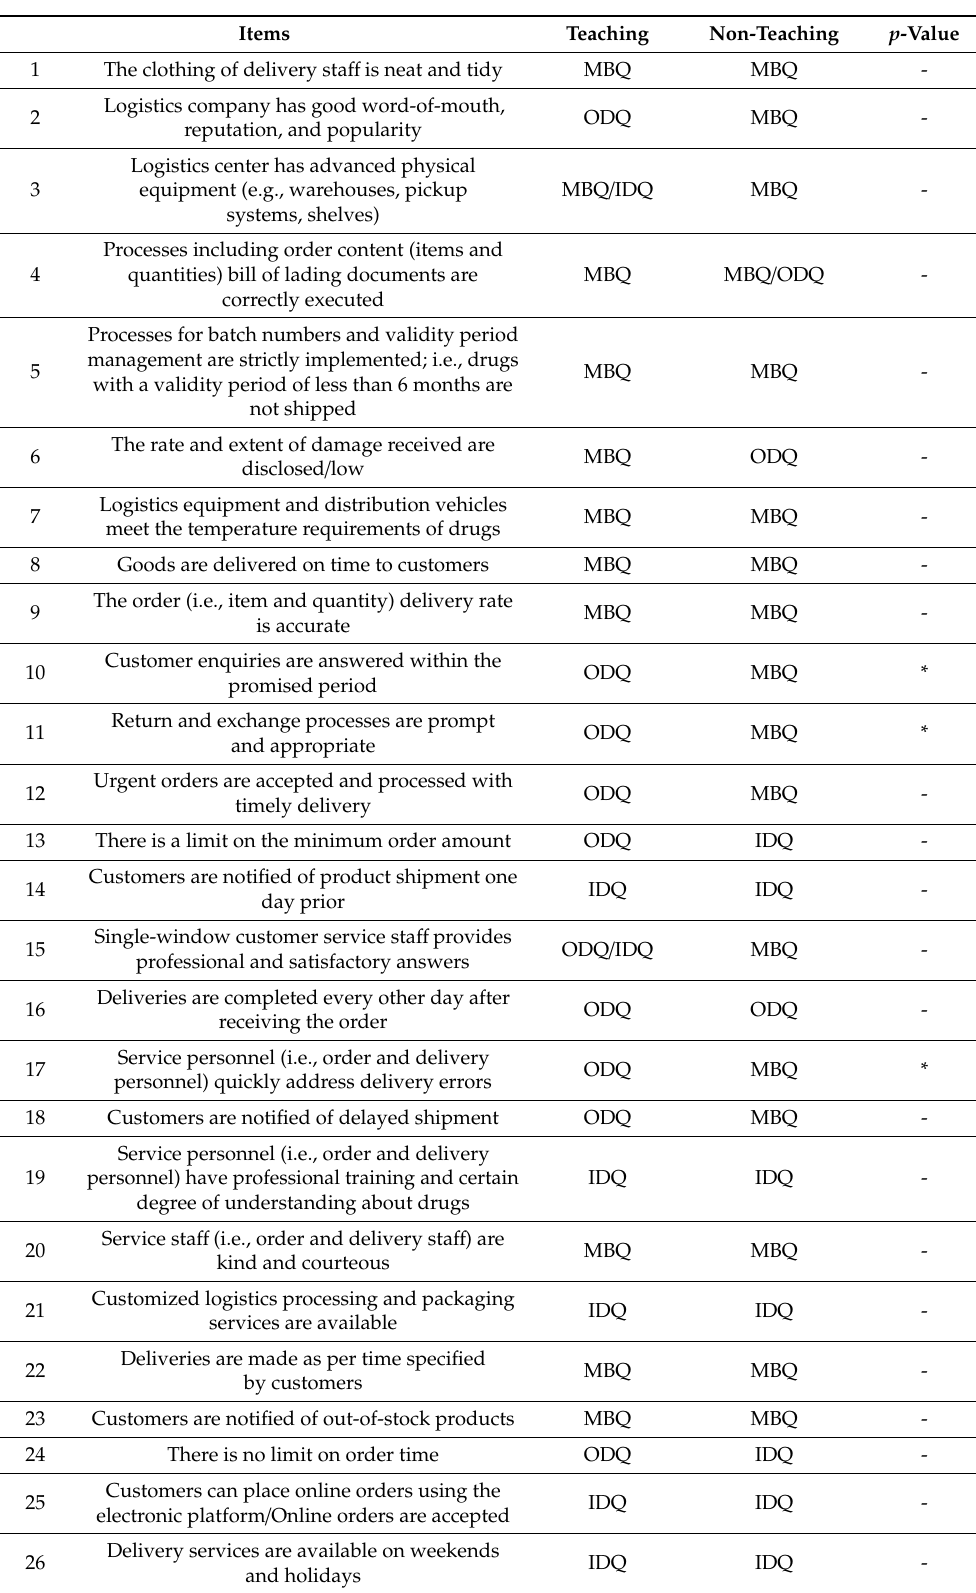
Table 4. Categorization of quality elements by teaching hospital and non-teaching hospitals.